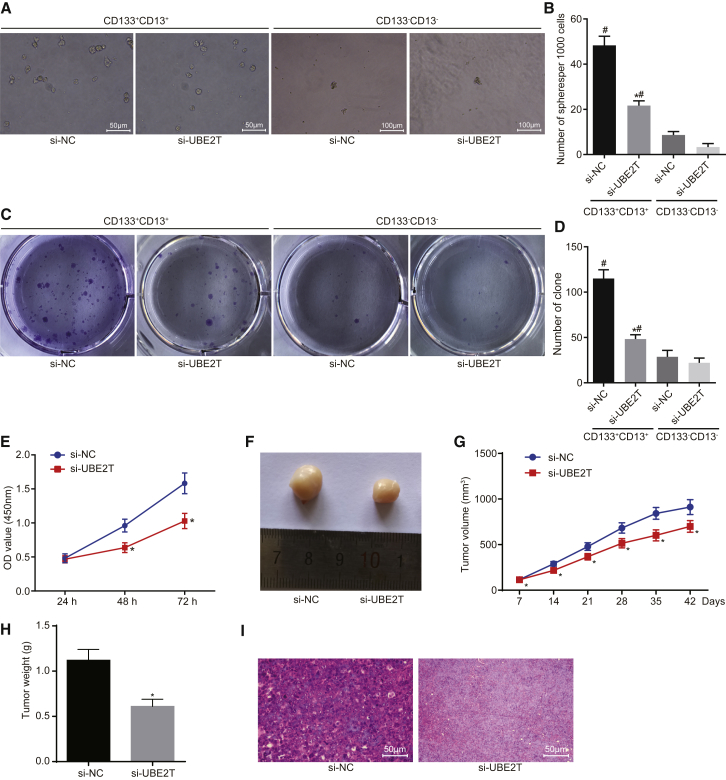
UBE2T Promoted the Tumorigenic Potential of LCSCs(A) Sphere formation ability of LCSCs in the presence of UBE2T silencing (200×). (B) The number of newly formed spheres. (C) Colony formation ability of LCSCs in the presence of UBE2T silencing, determined by soft agar colony formation assay. (D) The number of newly formed colonies. (E) The proliferative ability of LCSCs transfected with UBE2T silencing, assessed by CCK-8 assay. (F) Observation of tumors in nude mice. (G) The tumor volume in nude mice injected with UBE2T silencing-transfected LCSCs, measured by Vernier caliper. (H) The tumor weight in nude mice injected with UBE2T silencing-transfected LCSCs. (I) The pathological characteristics of tumor tissues in nude mice observed by H&E staining (400×). si-NC group, LCSCs transfected with si-NC or nude mice inoculated with si-NC-transfected LCSCs; si-UBE2T mimic group, LCSCs transfected with UBE2T silencing or nude mice treated with UBE2T silencing-transfected LCSCs. *p < 0.05 versus LCSCs transfected with si-NC or nude mice inoculated with si-NC-transfected LCSCs; #p < 0.05 versus CD13−CD133− cells. Statistical data were described as mean ± SD. Data between two groups were analyzed by unpaired t test, and data in (E) and (G) were compared by repeated-measures ANOVA. The experiment was repeated 3 times independently (n = 6).